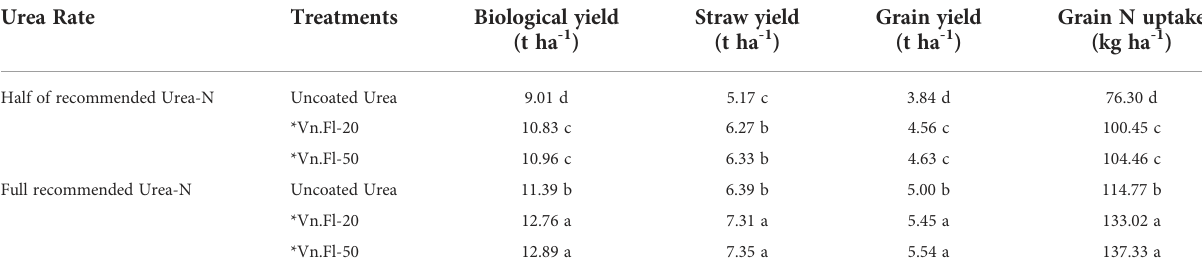
TABLE 4 Interaction effect of Vachellia nilotica extract coated urea and rate of urea-N application on Yield and N uptake of wheat under fi eld conditions (2019-20). Urea Rate